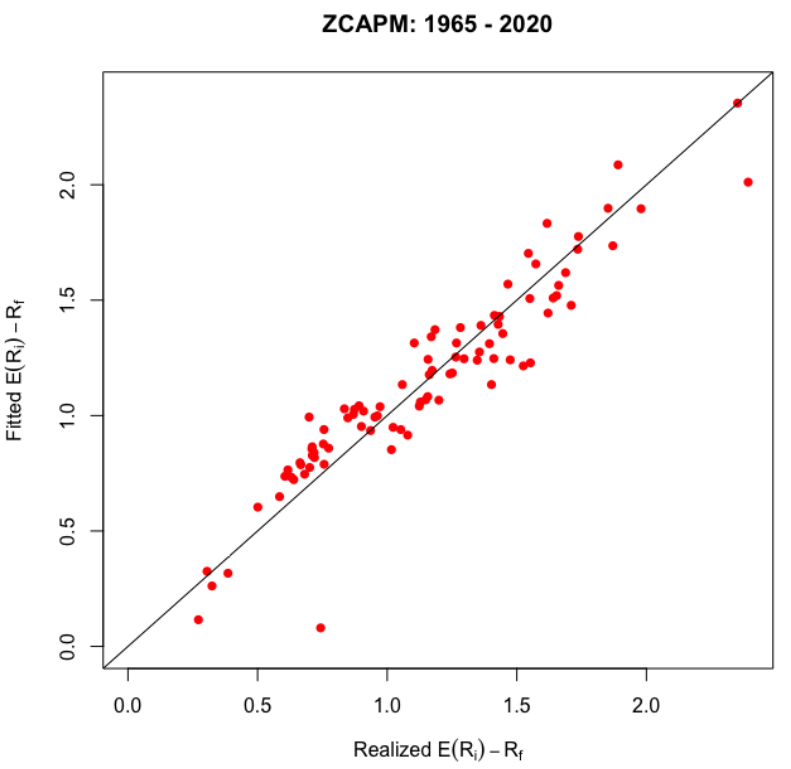
Figure 10. Out-of-sample cross-sectional relationships for the ZCAPM between average one-month- ahead fitted (predicted) excess returns in percent ( y -axis) and average one-month-ahead realized excess returns in percent ( x -axis): January 1965 to December